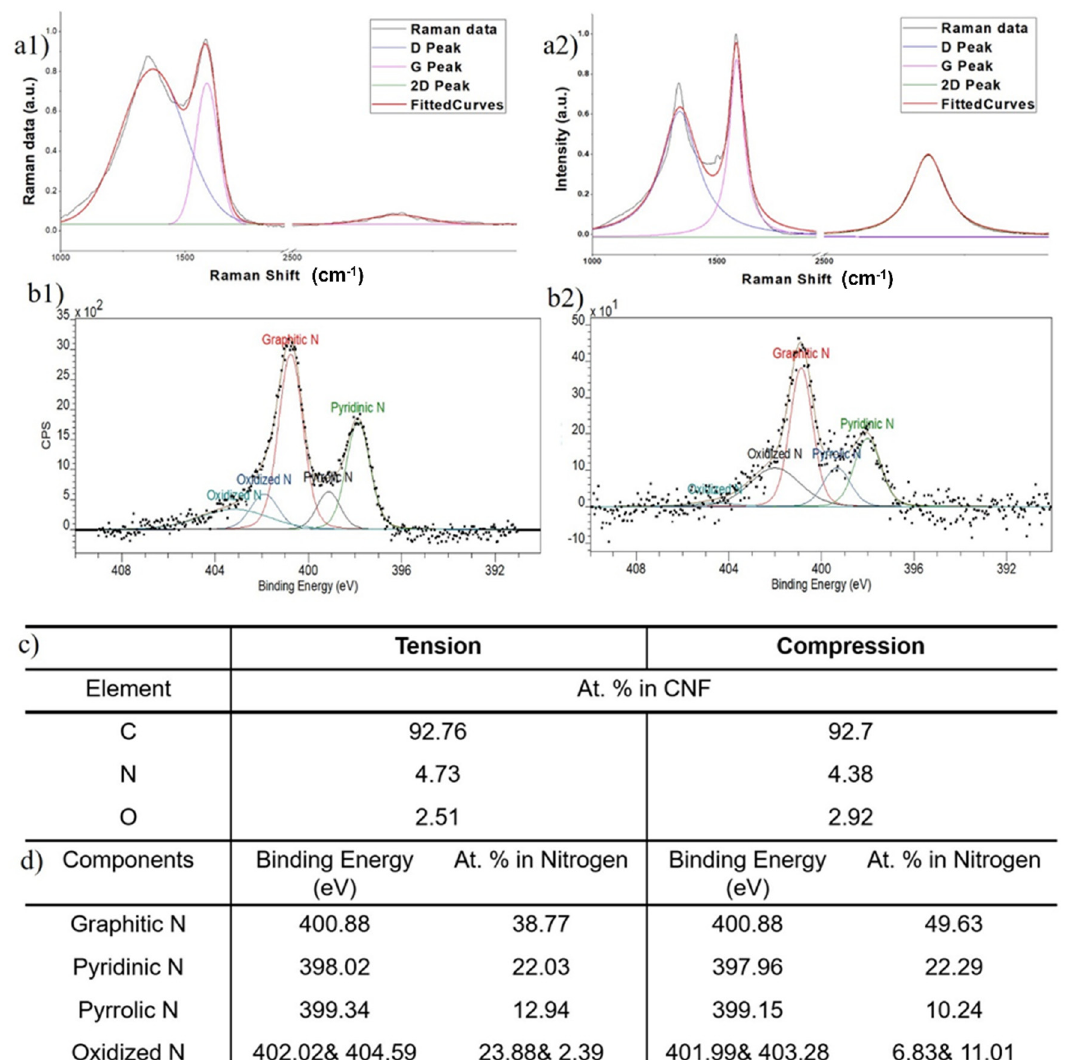
Figure 3. ( a ) Raman spectroscopy of ( a1 ) tension-induced (TIPC) and ( a2 ) compression-induced (CIPC) pyrolytic carbons ( λ excitation = 532 nm). ( b ) XPS spectra of the N 1s peaks of ( b1 ) TIPC and ( b2 ) CIPC. ( c ) Table of elemental composition of the TIPC and CIPC as determined by analysis of XPS spectrum. ( d ) Distribution of graphitic, pyridinic, and pyrrolic nitrogen as the main heteroatoms in TIPC and CIPC, as determined by analysis of XPS spectrum.